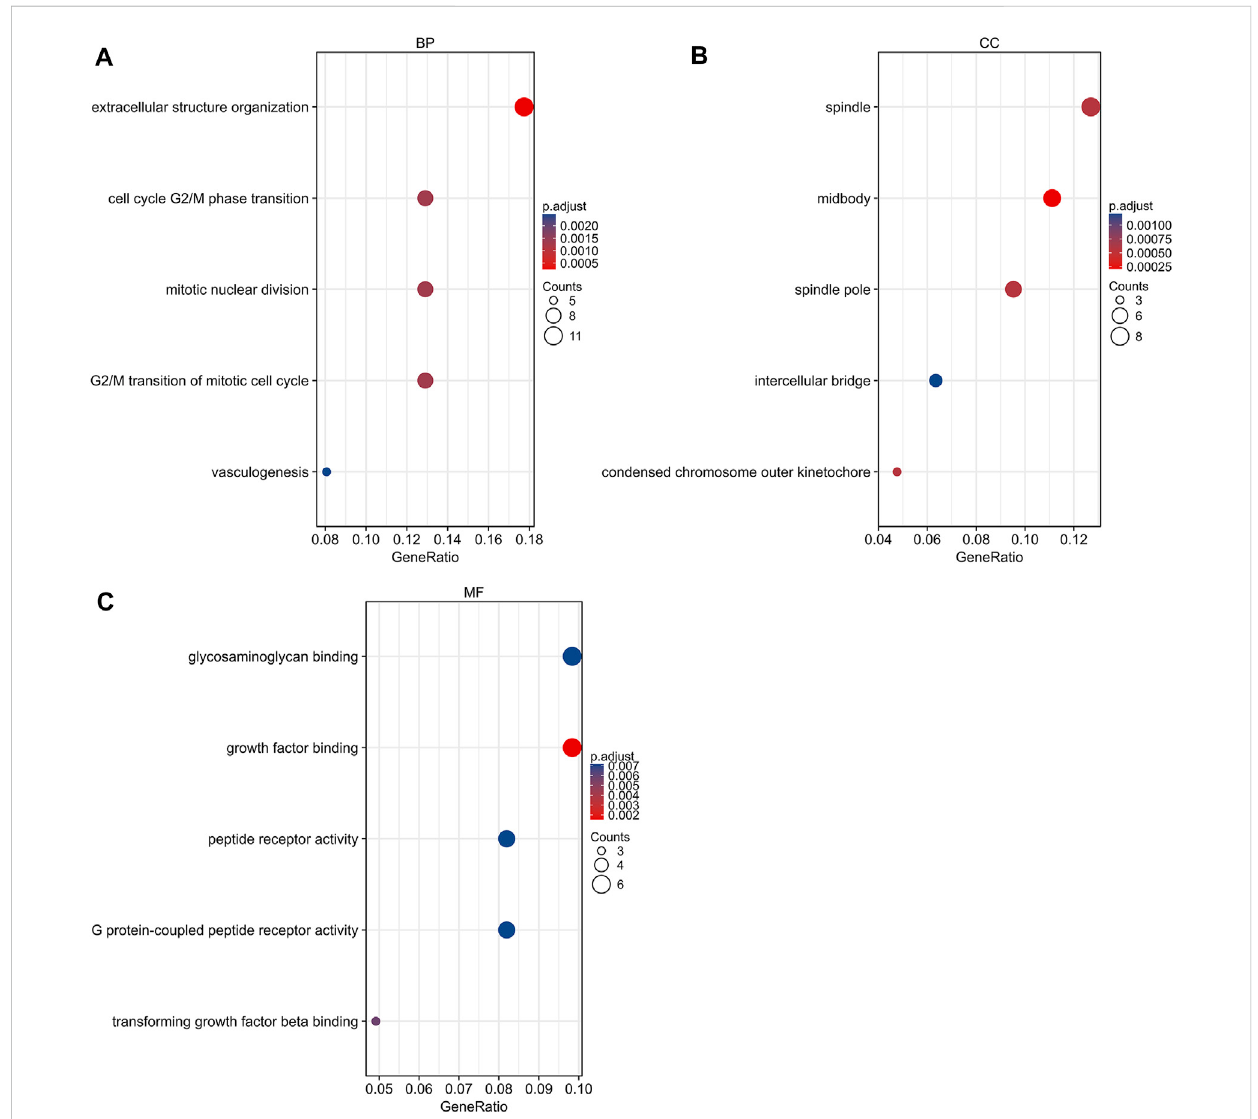
FIGURE 3 GeneontologyanalysisofDEGs. (A) BiologicalprocesstermsofDEGs. (B) CellularcomponenttermsofDEGs. (C) MolecularfunctiontermsofDEGs. DEG, differentially expressed